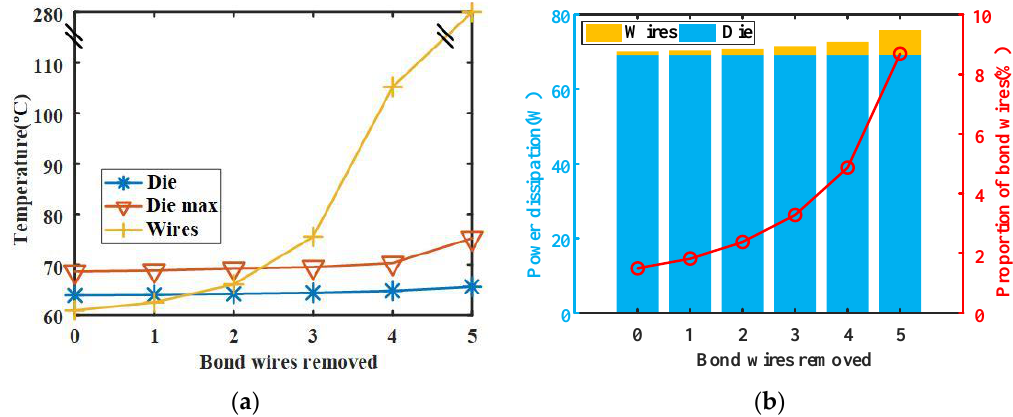
Figure 8. ( a ) Temperature of die and wires after bond wires removed ( b ) Power dissipation of die and wires after bond wires removed.